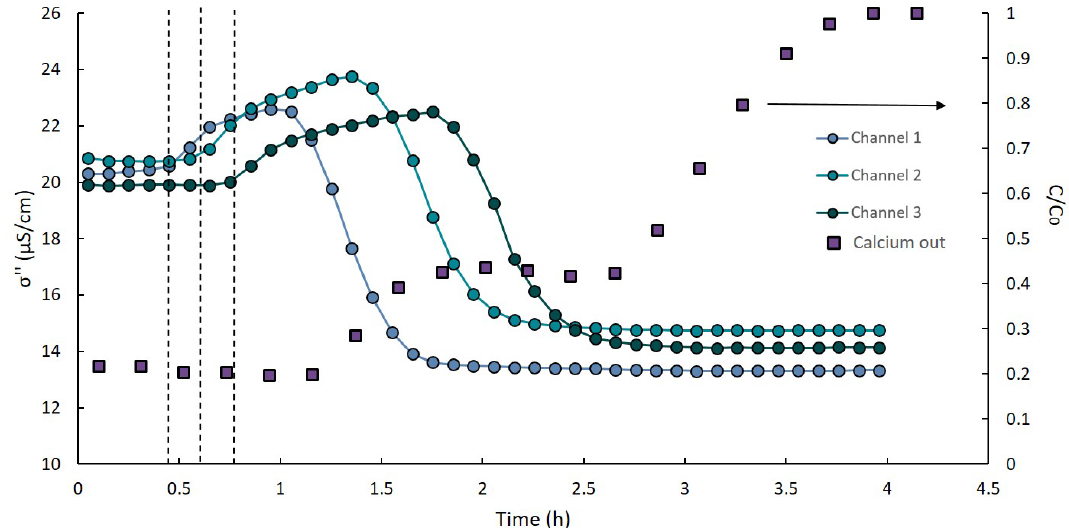
Figure 5. Imaginary conductivity at 1Hz vs. time at three locations (left vertical axis) and outflow Ca 2 + / Ca 2 + The vertical dashed lines represent the beginning of the increase in σ (cid:48)(cid:48) at each of the channels.